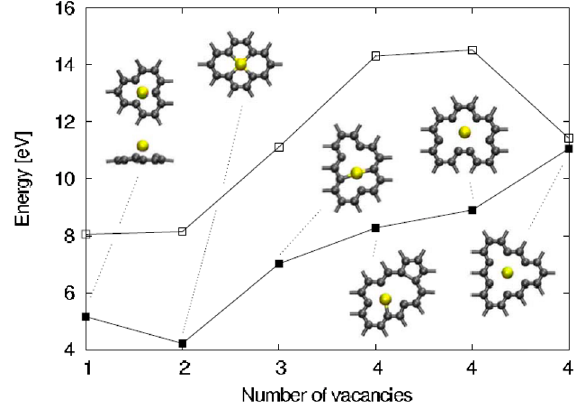
Figure 7. Carbon vacancies formation energy in graphene (empty squares), and formation energies for Au adsorbed in graphene vacancies (full points). For each vacancy, the insets show the selected geometry for the vacancy. Reproduced from Reference [98] with permission from the American Institute of Physics.